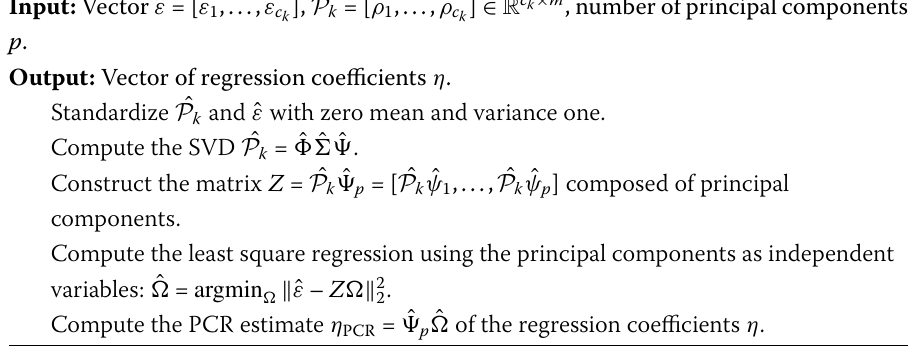
Algorithm 3 Surrogate error model using